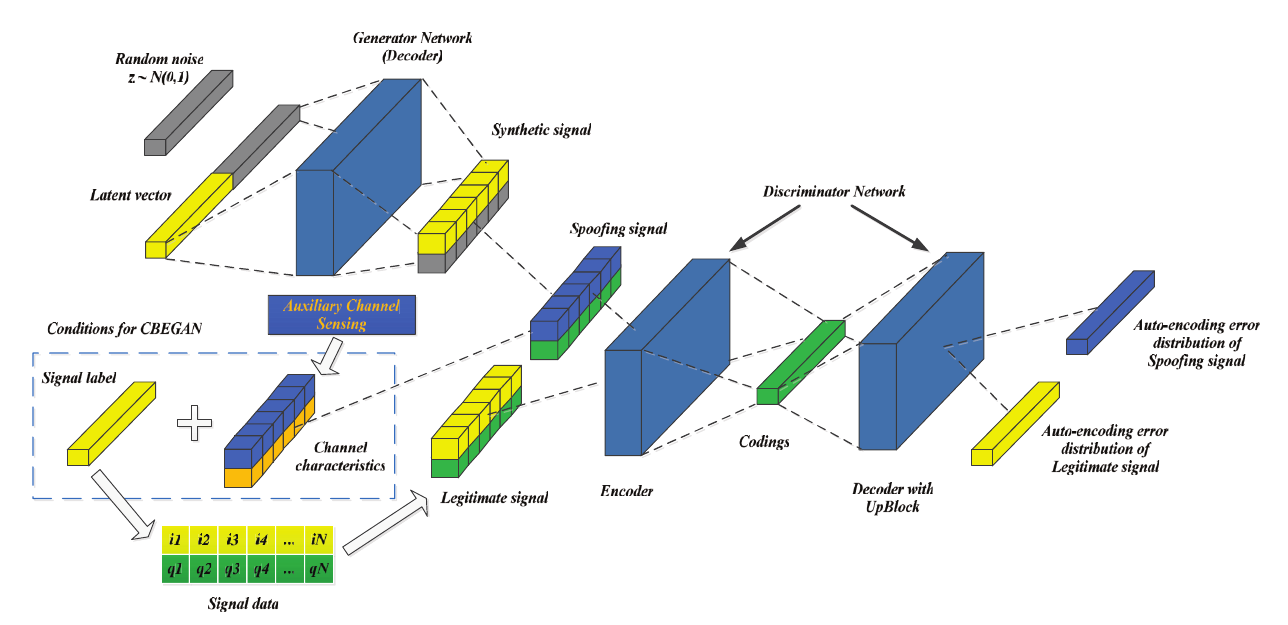
Figure 2. The structure of the proposed scheme based on CBEGAN and auxiliary channel